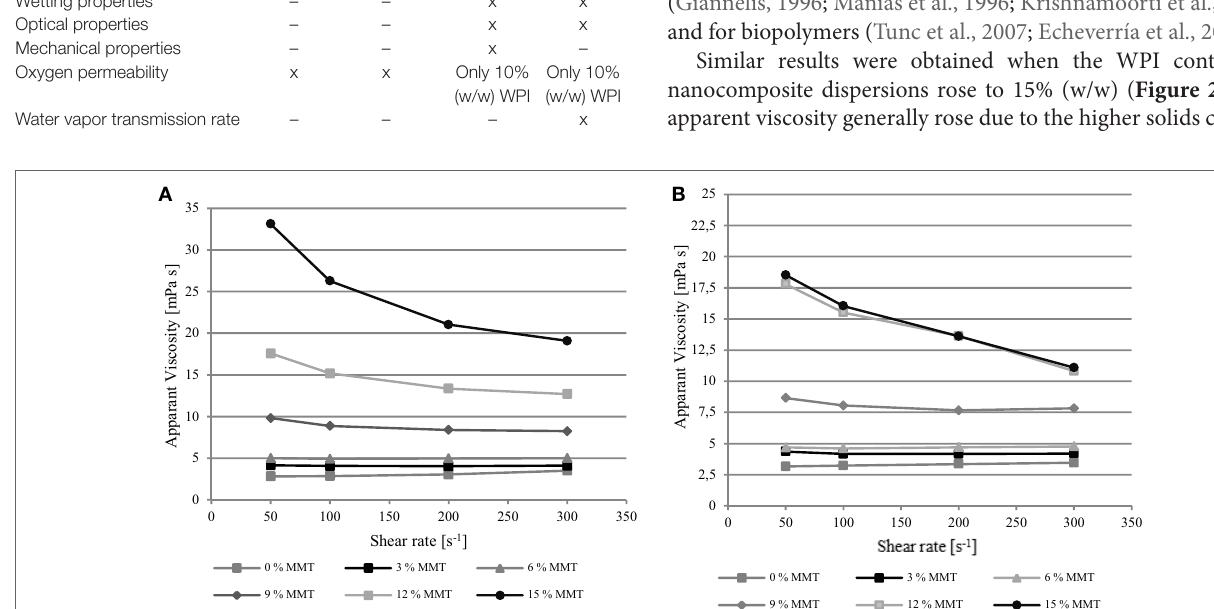
FigUre 1 | Apparent viscosity dependent on the shear rate from 50 to 300 [s − 1 ] of native whey protein isolate (WPI)-based nanocomposite dispersions with 10% (w/w) WPI, 66.70% (w/w protein), and an increasing montmorillonite (MMT) nanofiller loading, plasticized with (a) glycerol or (B) sorbitol.